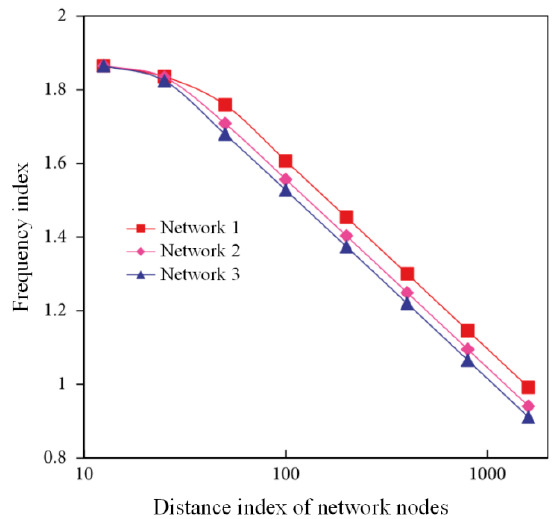
Figure 7. Distance analysis of nodes in intelligent transportation logistics network.